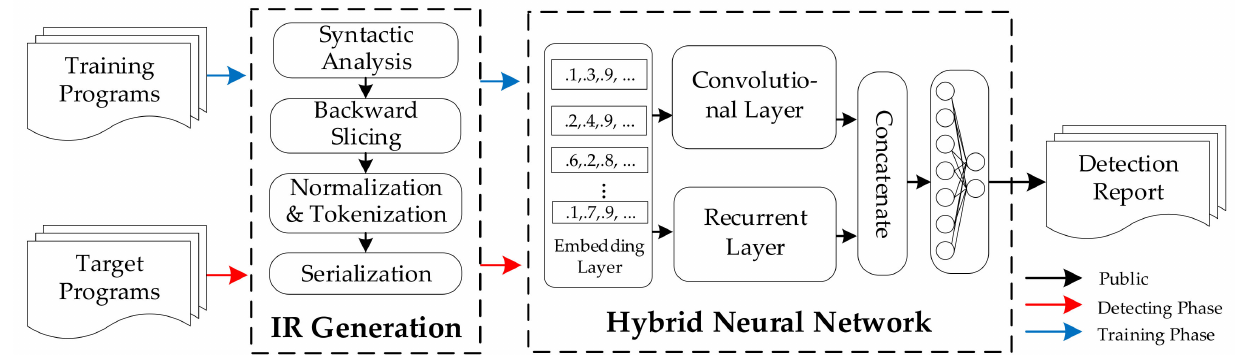
Figure 1. Overview of the proposed vulnerability detection approach. The red arrow represents the data flow in the training phase. The blue arrow represents the data flow in the detection phase. The black arrow represents the data flow in both the training and detecting